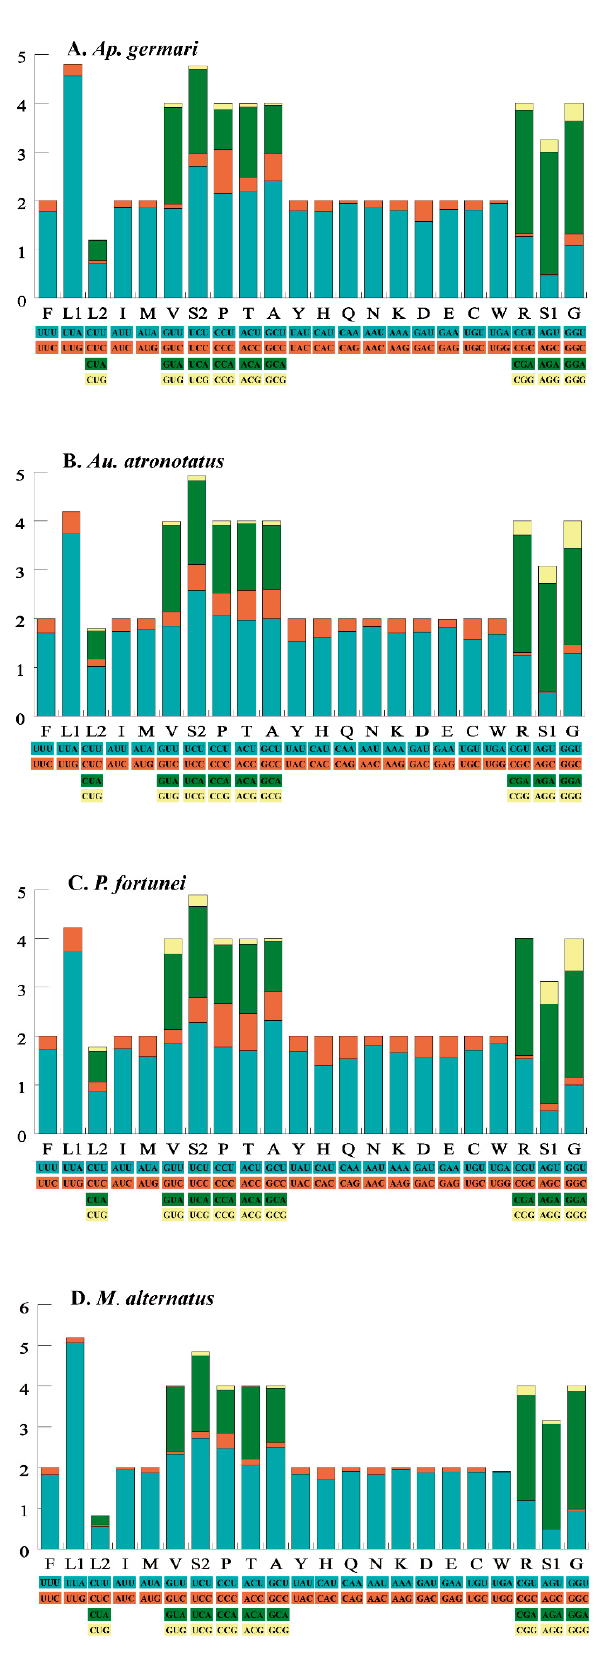
Figure 2. The relative synonymous codon usage (RSCU) of the 13 protein-coding genes. Codon families are provided on the x-axis along with the different combinations of synonymous codons that code for that amino acid. RSCU is defined on the Y axis.